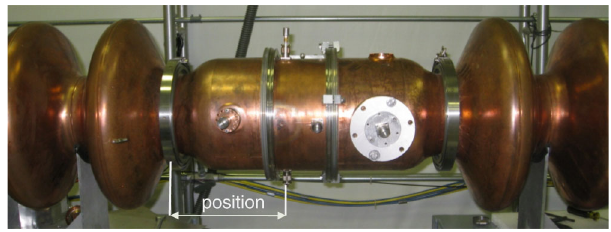
FIG. 19. Connecting tube with damper ring between Cu cavities.